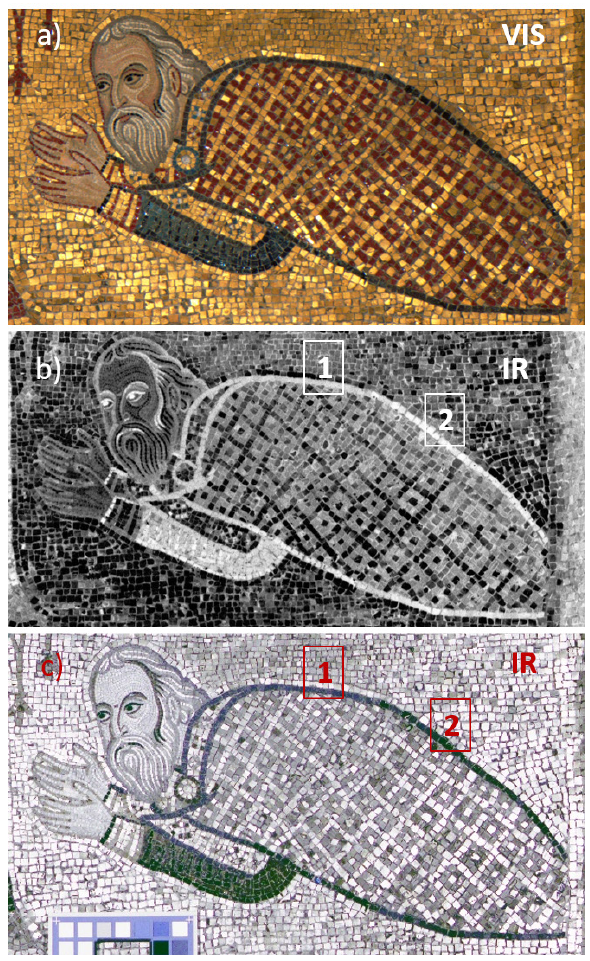
Figure 10: Palermo, St. Mary of the Admiral, Dedication panel: identification of similar features in different zones with black tesserae in the wall mosaic using IR images.